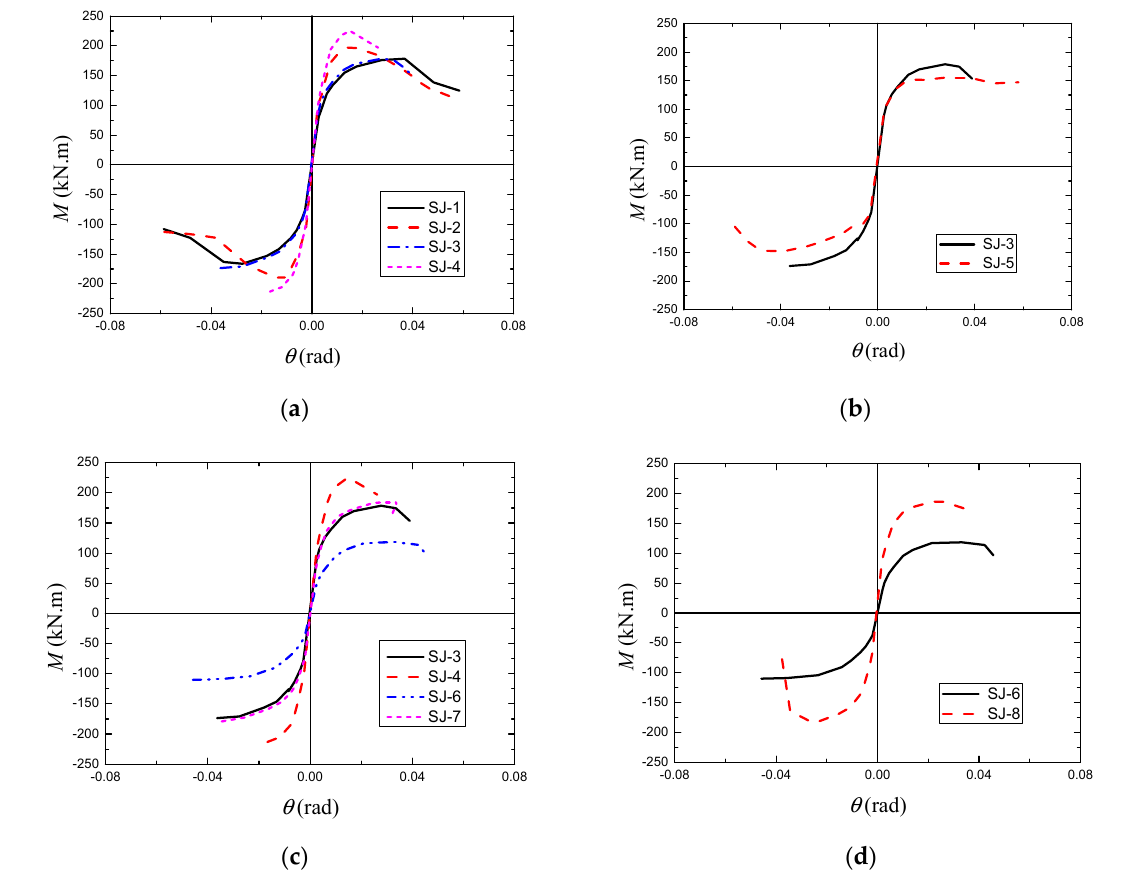
Figure 14. Comparison of the moment (M)-rotation ( θ ) envelope curves of the specimens; ( a ) Effect of steel tube thickness and end-plate thickness; ( b ) Effect of the local strengthening connection method and anchorage method; ( c ) Effect of the steel beam section, and ( d ) Effect of the stiffeners.